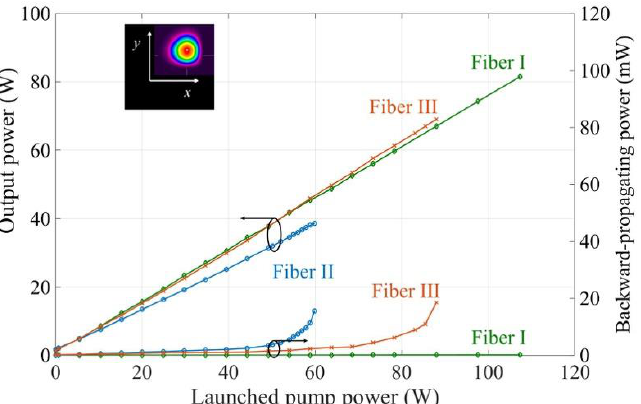
Figure 3. Output power (left axis) and backward SFS output power (right axis) measured versus launched pump power for fiber amplifiers utilizing 1.05 m of fiber I, 2.83 m of fiber II, or 3.28 m of fiber III. Inset is an image of the output mode profile, measured at 52 W of output power.